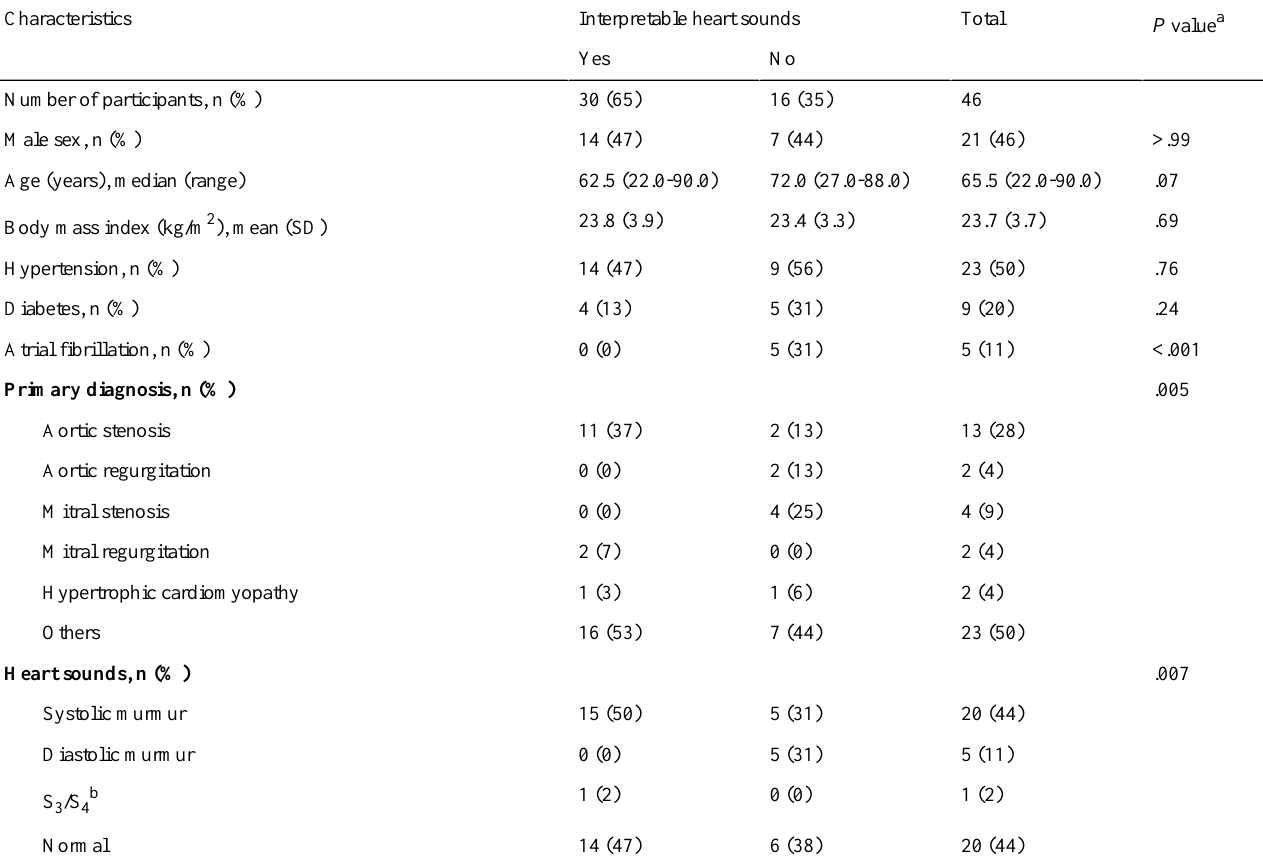
Table 1. Characteristics of study